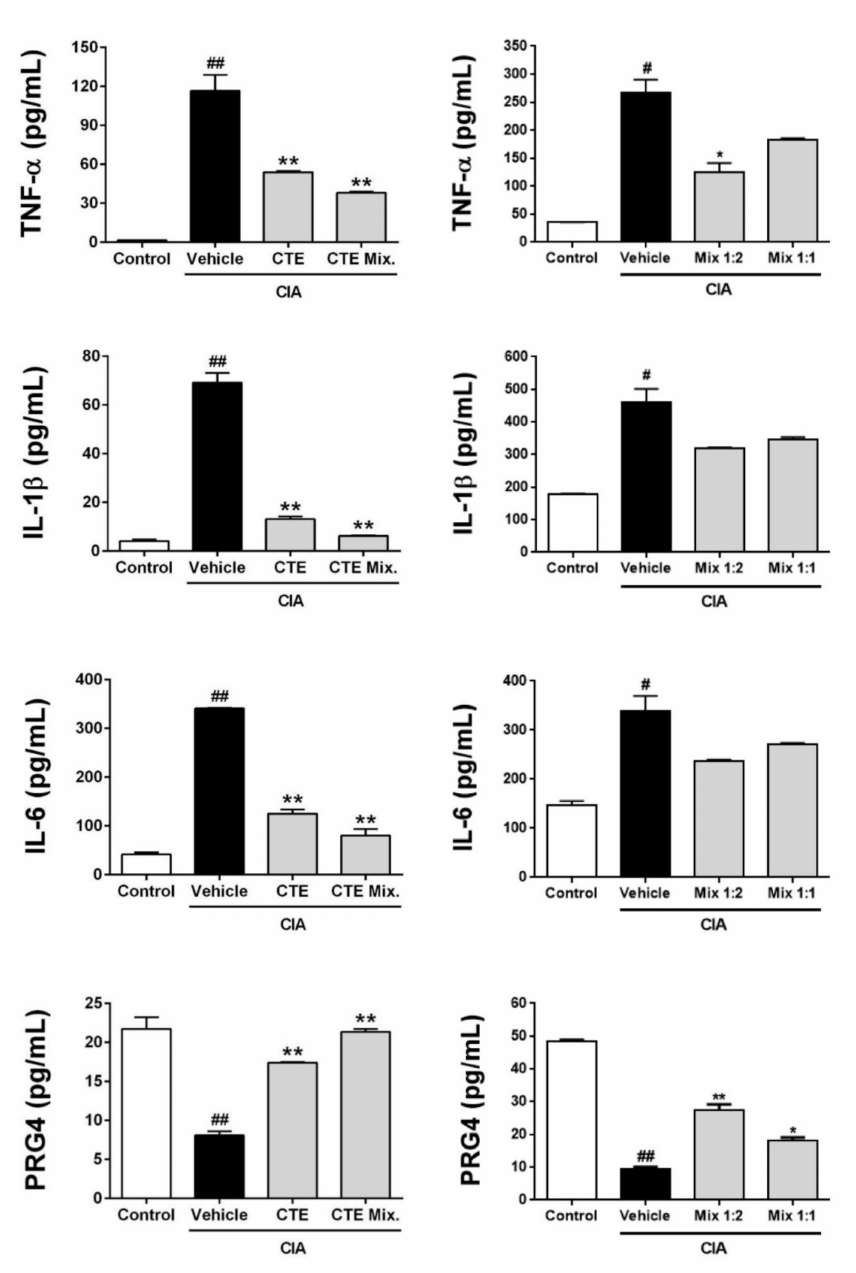
Figure 6. Effect of CTE and CTE mix on pro-inflammatory cytokines in CIA-induced animal model. The control group and vehicle group were orally administered physiological saline. In the CTE group, only CTE was administered orally, while in the CTE/SKE combination groups, these extracts were mixed at the respective concentrations of 2:1, 1:2, and 1:1 and administered orally. Inflamma- tory cytokine production and proteoglycan synthesis production by specimen administration were confirmed through ELISA (control vs. ## p < 0.01; vehicle vs. * p < 0.05, ** p < 0.01; n =